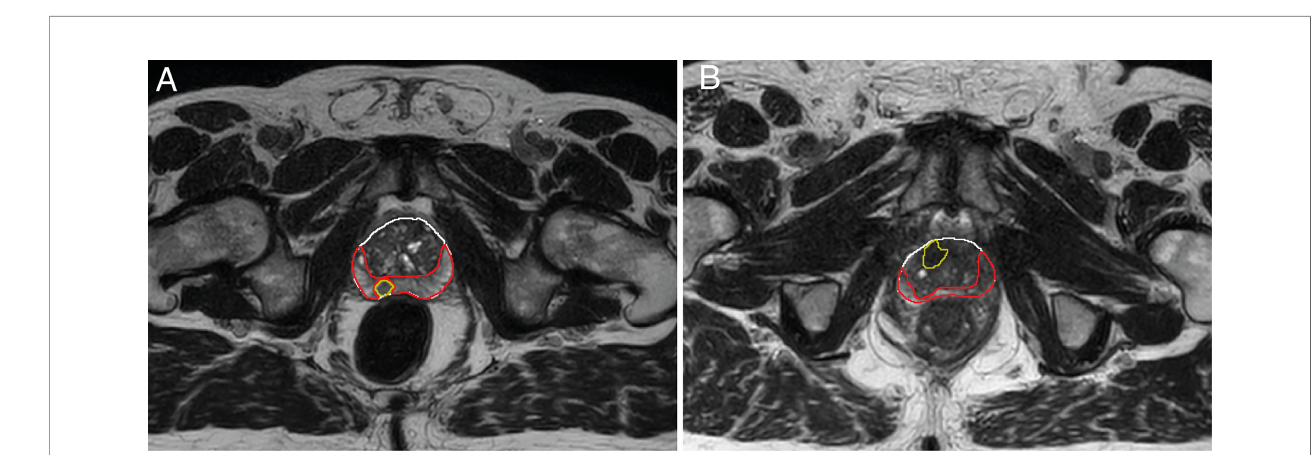
FIGURE 1 | Example of delineations of the different prostate zones of two different patients (A, B) . Delineations were made on T 2 -weighted scans from the fi rst treatment fraction. The entire prostate is shown in white, the peripheral zone (PZ) in red, and the tumor in yellow. The transition zone (TZ) was extracted in post processing by subtracting the PZ from the prostate delineation. Tumor voxels were excluded from all other zones during